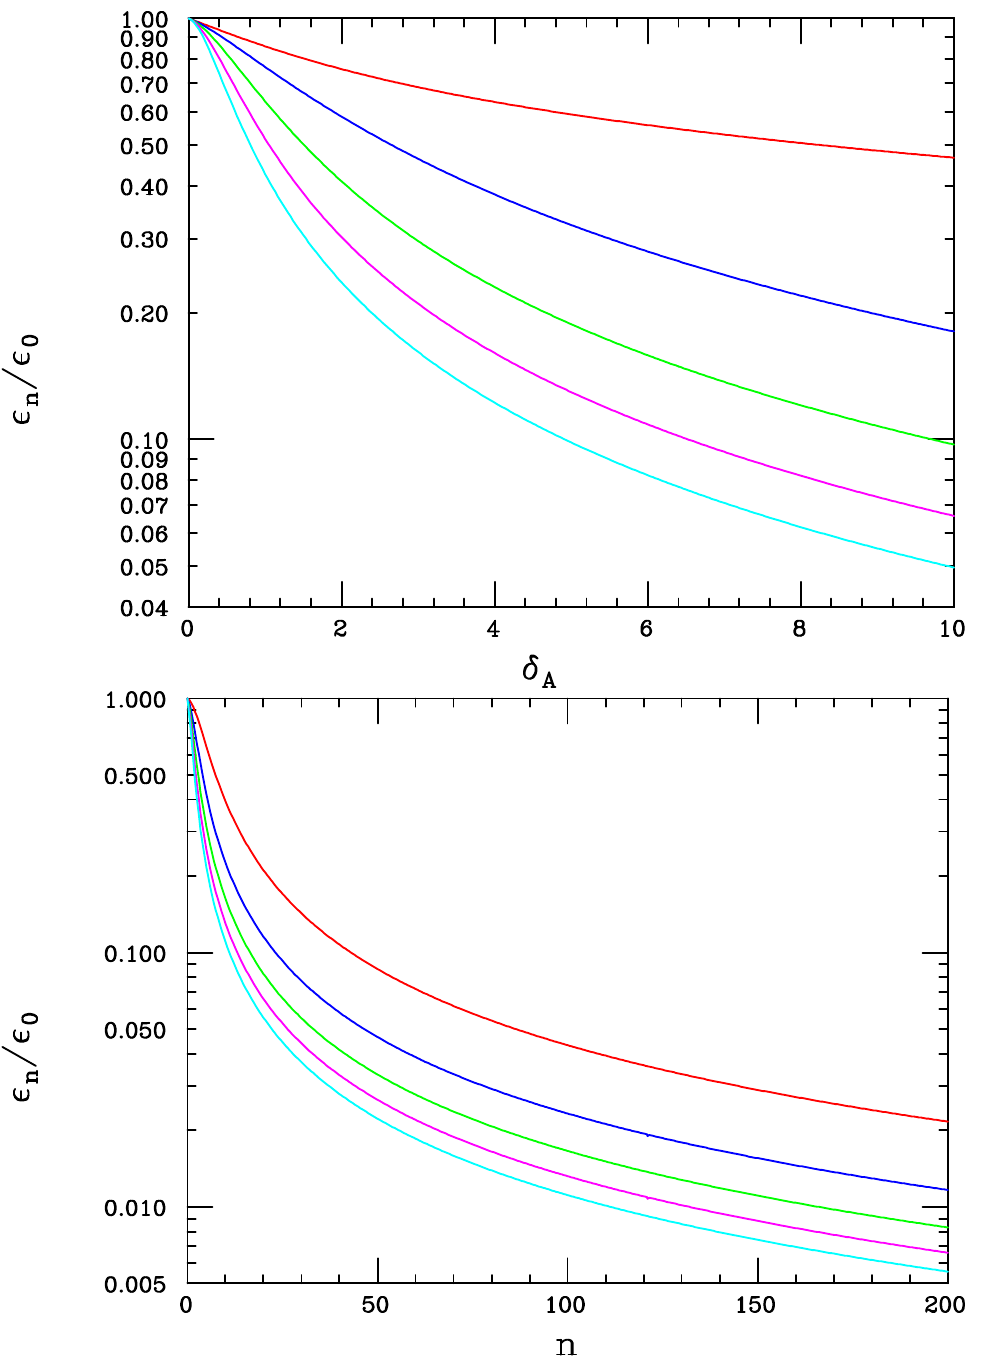
Figure 2 . Top: same as the top panel in the previous (cid:12)gure but now shown on a log scale. Bottom: the sane as the lower panel in the previous (cid:12)gure but now emphasizing smaller values of (cid:14) A , from top to bottom, the curves correspond to (cid:14) A = 0 : 5 ; 1 ; : : : ; 2 : 5.